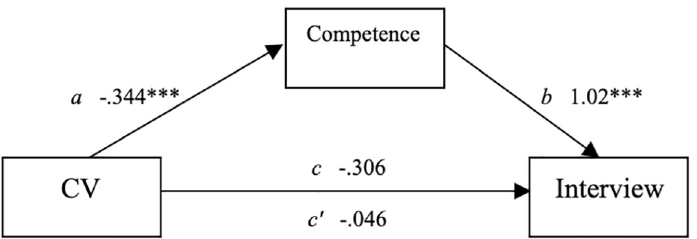
Fig 2. Unstandarized regression coefficient for the relationship between CV and interviews as mediated by competenence.